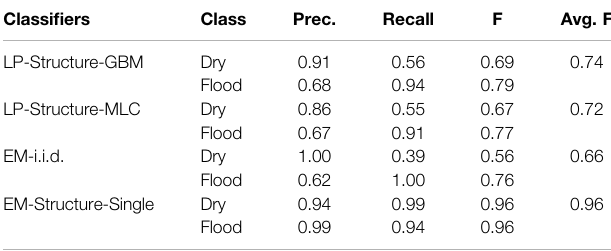
TABLE 3 | Comparison on Mathew, Kinston fl ood data.